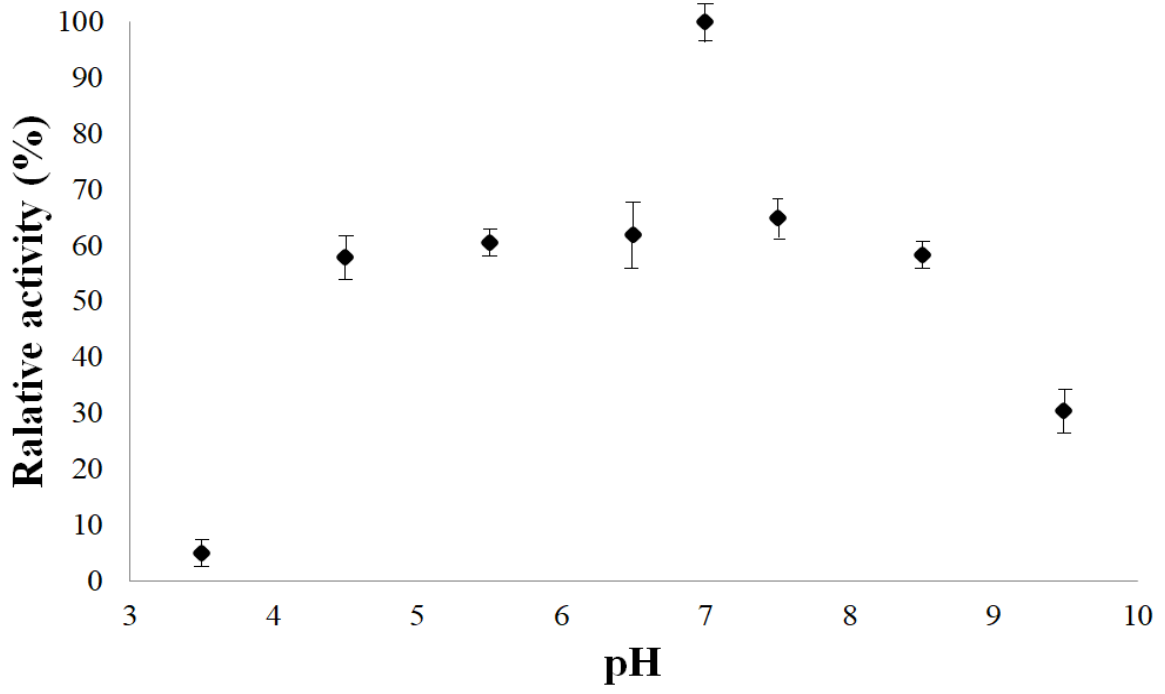
Figure 8. Effect of pH on the bromelain purified from pineapple at 30 °C.